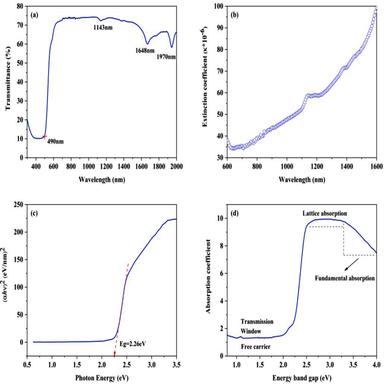
(a) UV–vis-NIR transmittance spectrum of DADMQ. (b) Wavelength dependence of extinction coefficient (κ) for DADMQ. (c) Tauc's plot of (αℎν) 2 against ℎν of DADMQ. (d) Plot of absorption coefficient against energy band gap of DADMQ.